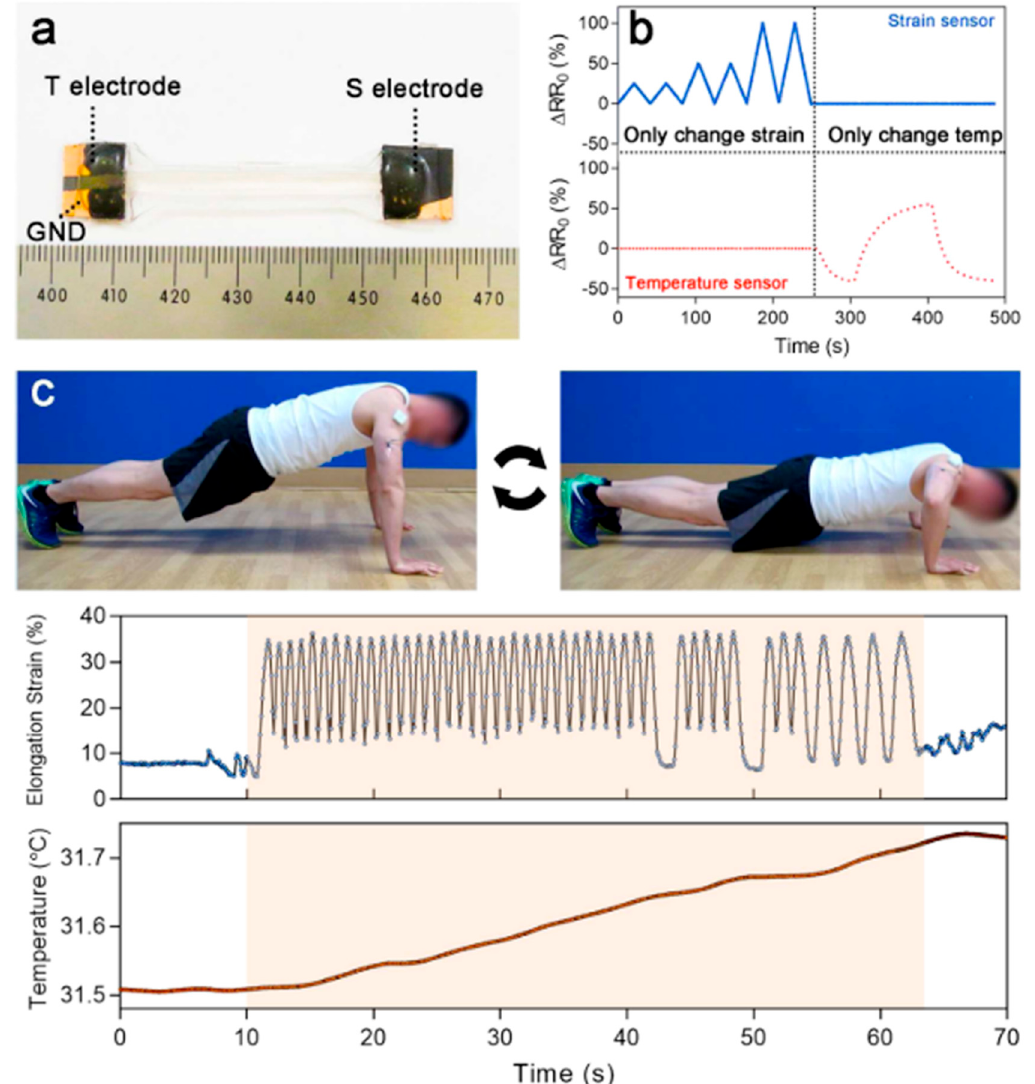
Figure 15. ( a ) Image of an iono-elastomer thermomechanical dual-responsive sensors with T (temperature) and S (strain) outputs and GND acting as a ground for the two electrodes. ( b ) Decoupled signals in response to first mechanical stress and then coming into contact with a cold and hot object. ( c ) Human subject undergoing high-intensity anaerobic exercise with real-time strain and temperature responses captured by the sensor depicted in ( a ). Reprinted with permission from [242]. Copyright American Chemical Society